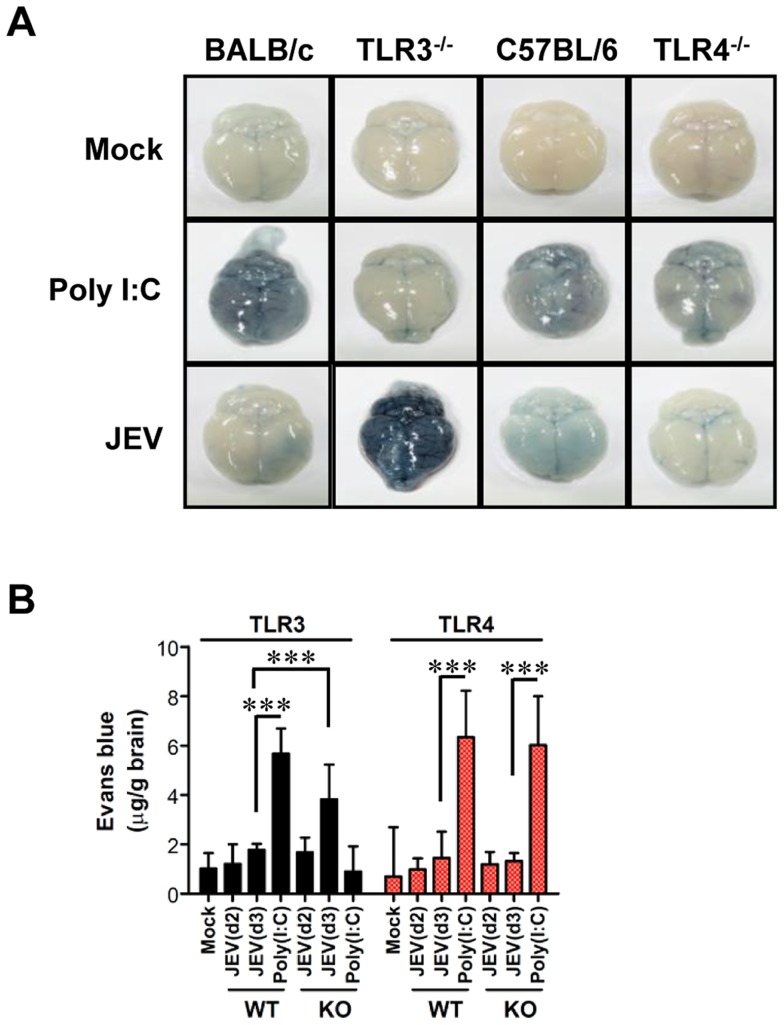
BBB permeability is increased after JEV infection in TLR3−/− but not TLR4−/− mice.TLR3−/− and TLR4−/− mice were given 1% Evans blue dye solution 2 and 3 days pi, and BBB permeability was evaluated by visualizing and quantifying extravasated Evans blue dye following vigorous heart perfusion. Mice injected with poly(I:C) were used as a positive control. A. Picture of extravasated Evans blue staining of whole brain 3 days pi. B. The amount of Evans blue dye diffused into whole brain. The amount of Evans blue dye was quantified by measuring the absorbance after tissue homogenization and precipitation. Data represent the average ± SD derived from six to eight mice per group. ***, p<0.001 compared with the levels of the indicated group.